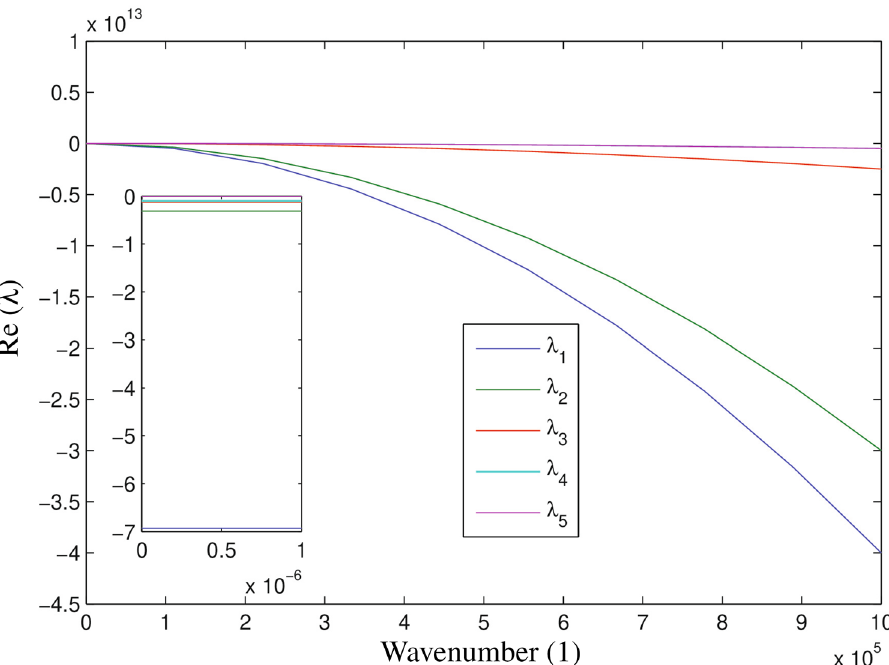
Figure 3. Numerically simulated dispersion curves for the model system (1)–(5) of wavenumber(l) (x-axis) against the real part of (cid:31) (y-aixs) with D G = 55, D M = 5, D T = 400, D C = D I = 25 and rest of the parameters are defined in Table 1. Five different curves are designate for different eigenvalues. The dispersion curve is computed by obtaining the real part of eigenvalues for the linearized system by varying the wavenumber(l) from zero in increments of 0.001.